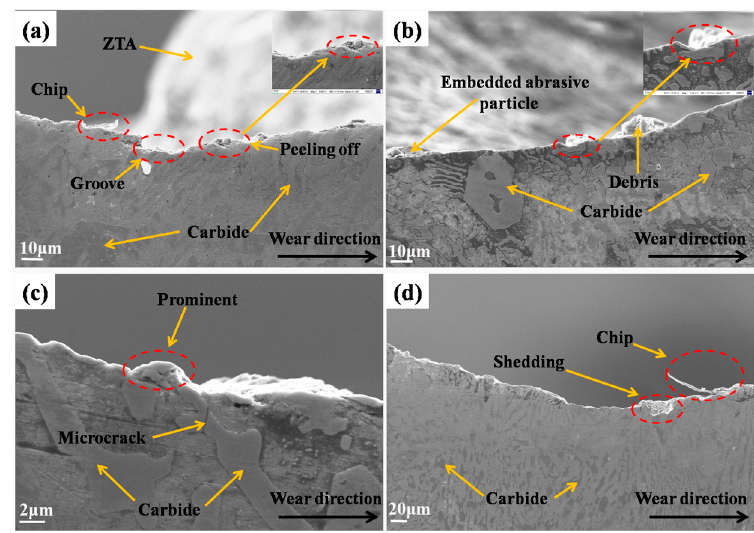
Figure 11. Worn subsurface in the honeycomb wall and the honeycomb column of the composite: ( a , b ) Honeycomb wall; ( c , d ) Honeycomb Core.